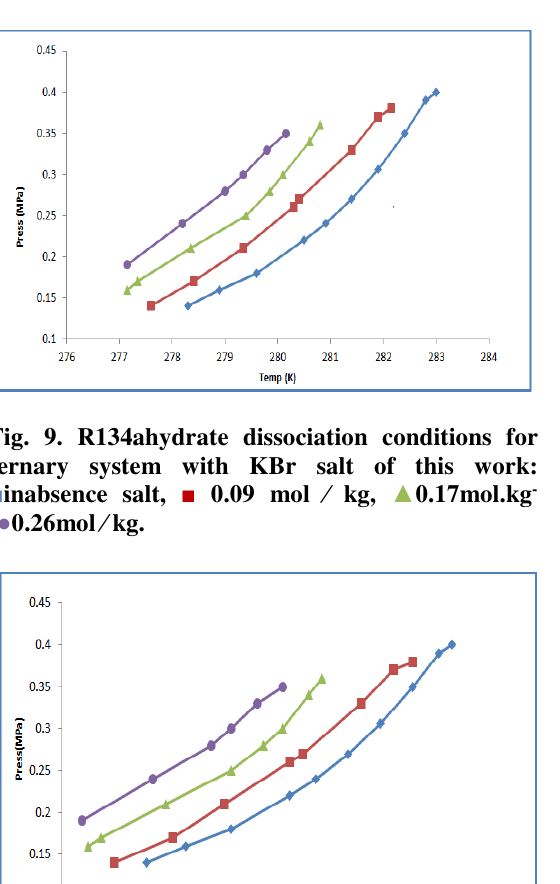
The plot of Ln P vs. 1 ∕ T for dissociation data of the of present work to obtain the heat of dissociation forR134a hydrate was shown in fig. (11).